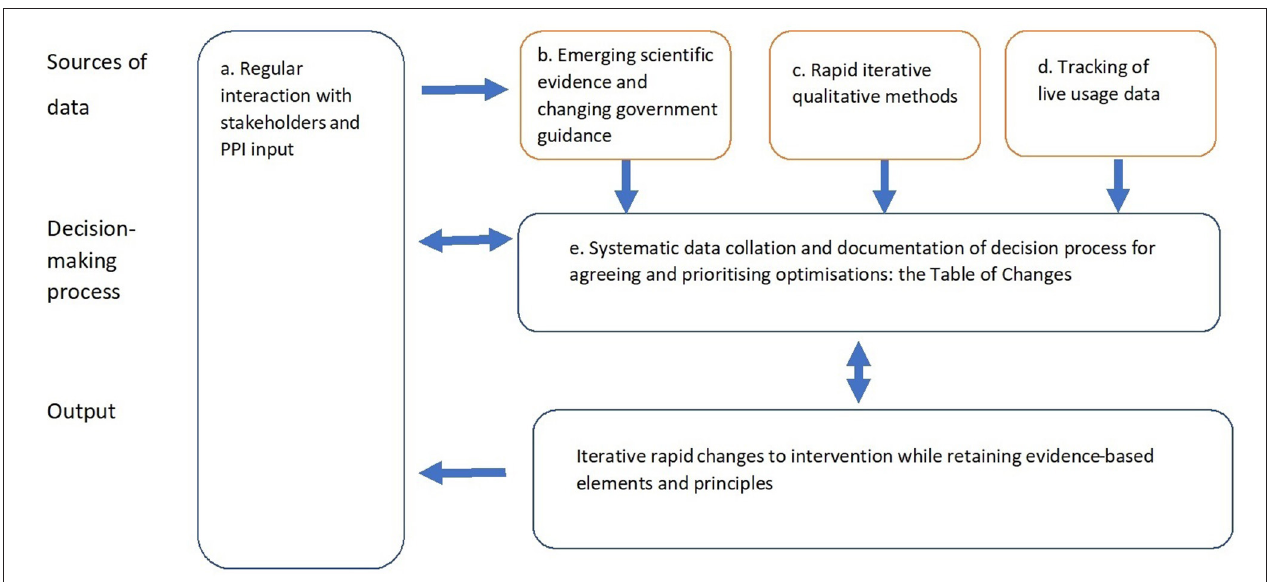
FIGURE 1 | Rapid optimisation